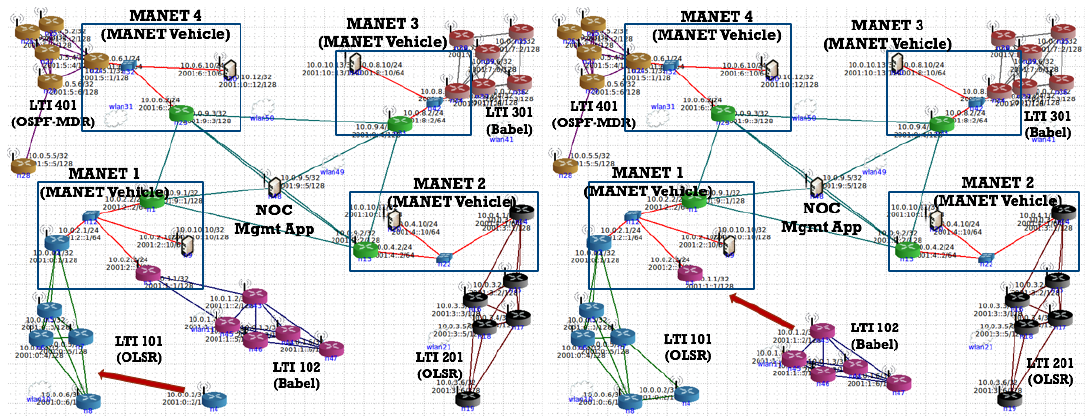
Figure 7. Scenarios of Unit